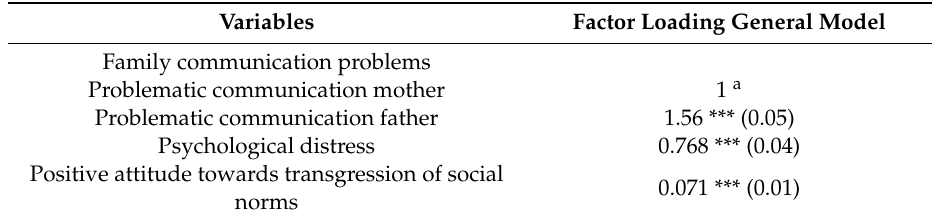
Table 2. Factorial saturations, standard error, and associated